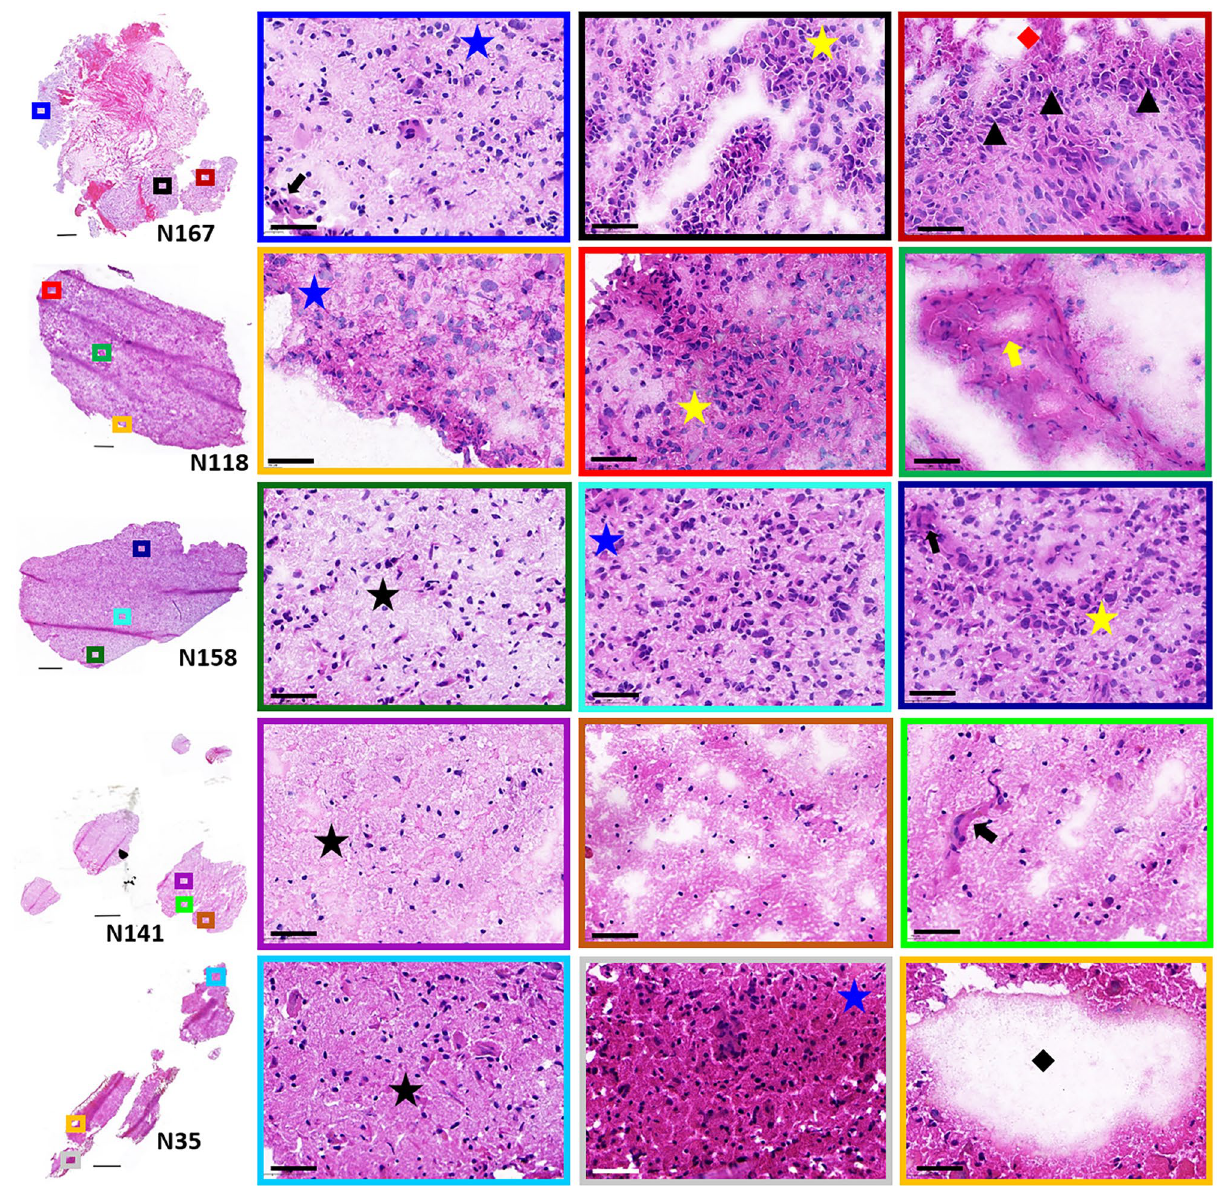
Figure 1. H&E stained sections of patient glioblastoma samples. Higher magnification of representative regions are shown in the colored boxes. Histologic features include low (black star), moderate (blue star) and high (yellow star) tumor cell densities, pseudopalisading tumor cells (black arrow-head), microvascular sprouting (black arrow) and vascular garland formations (yellow arrow), necrosis (red diamond) and acellular fluid-filled regions (black diamond). Scale bars are 50